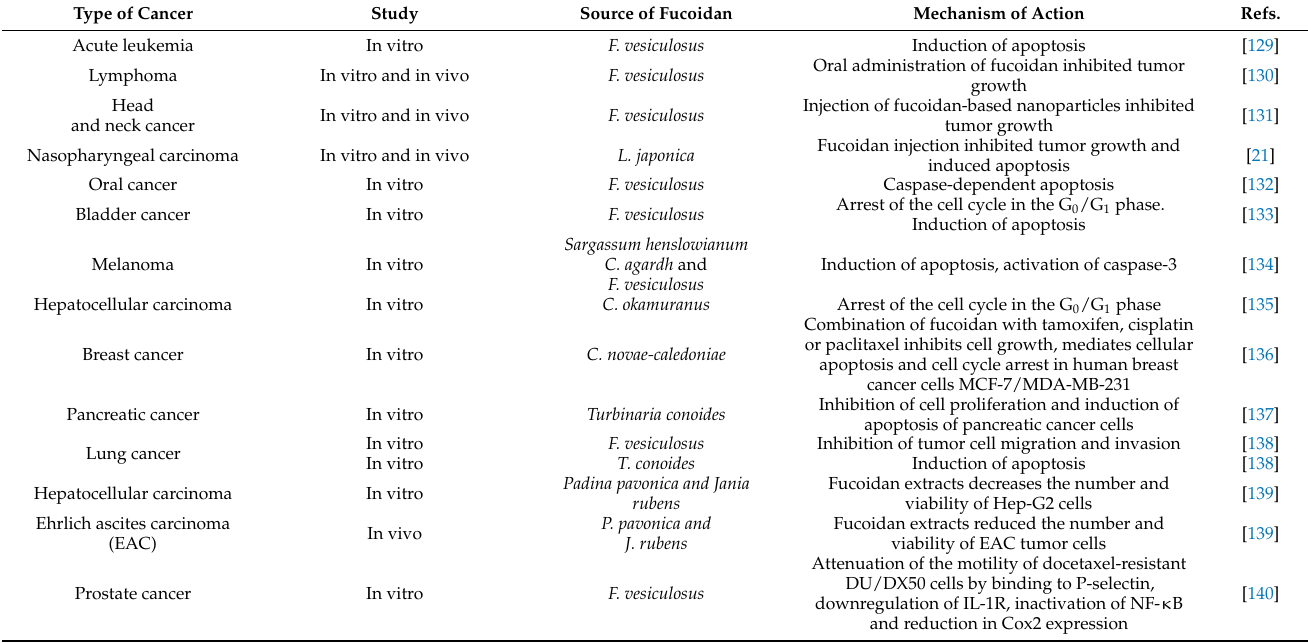
Table 1. Antitumor activity of